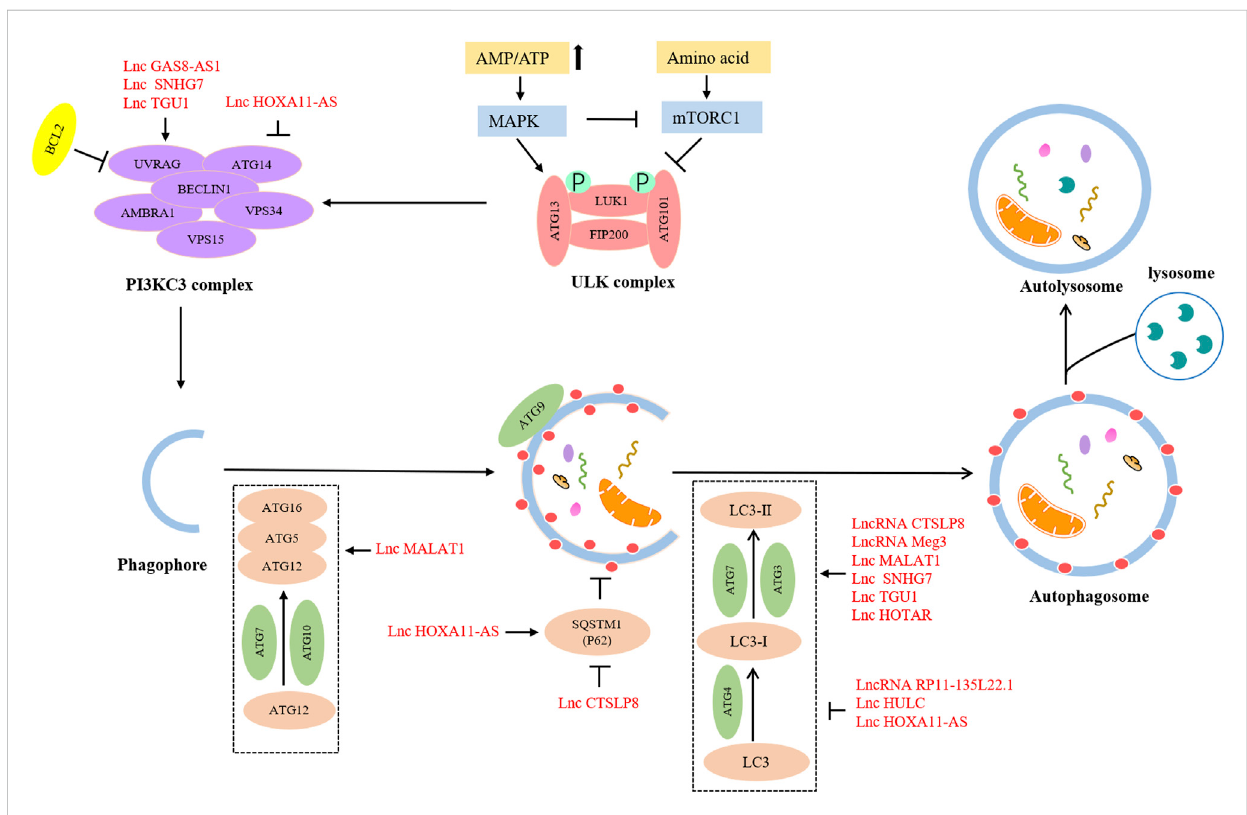
FIGURE 3 Roles of lncRNAs in autophagy regulation in